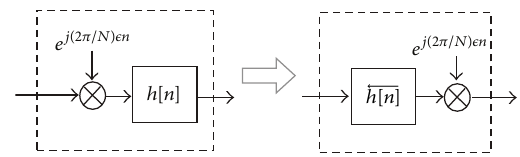
Figure 3: Exchanging the positions of a phase rotator and an FIR